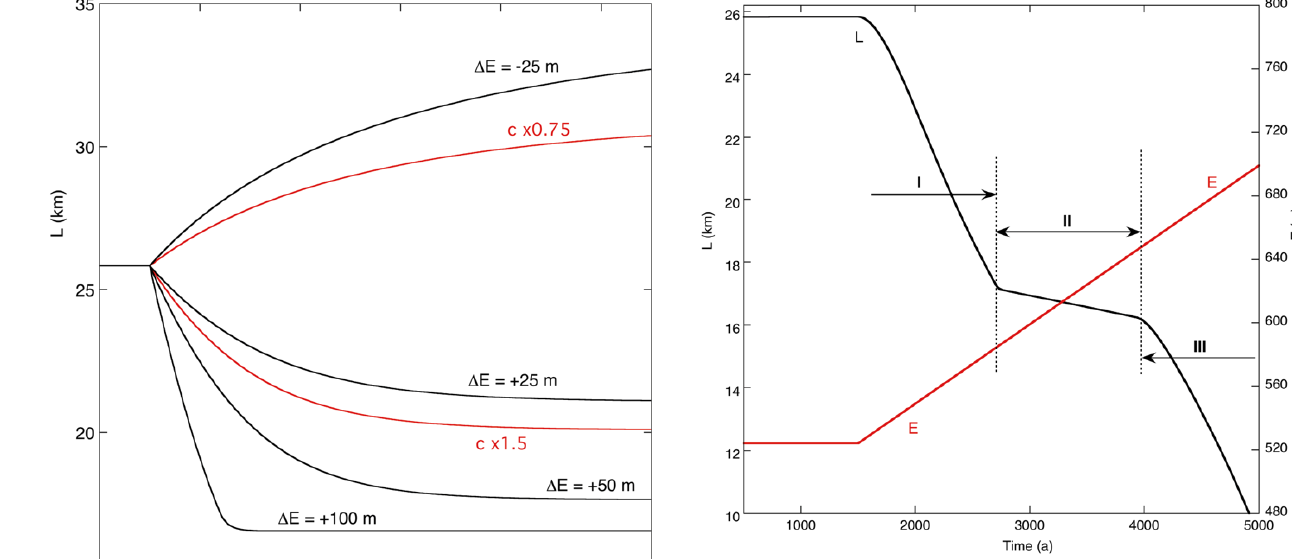
Figure 6. Glacier length L for a very slowly increasing ELA ( E ). Three regimes are identified (I, II, III) for which the sensitivity of glacier length to the ELA ( ∂L/∂E ) differs